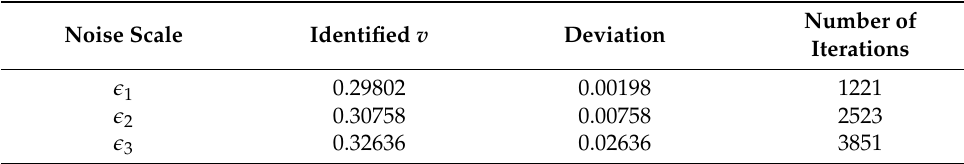
Table 1. Comparison of different noise scales for inversion.